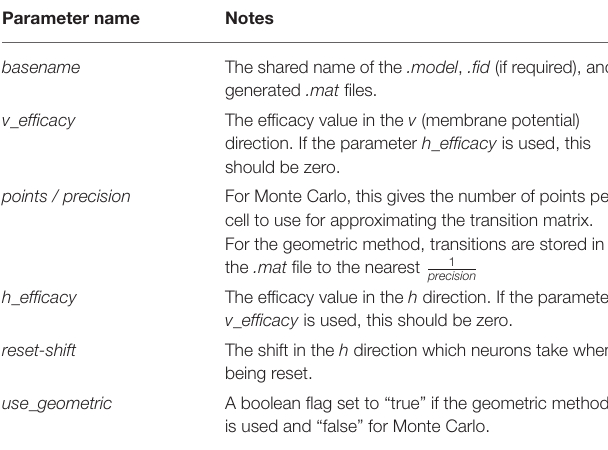
TABLE 3 | Parameters for the generate-matrix command in the